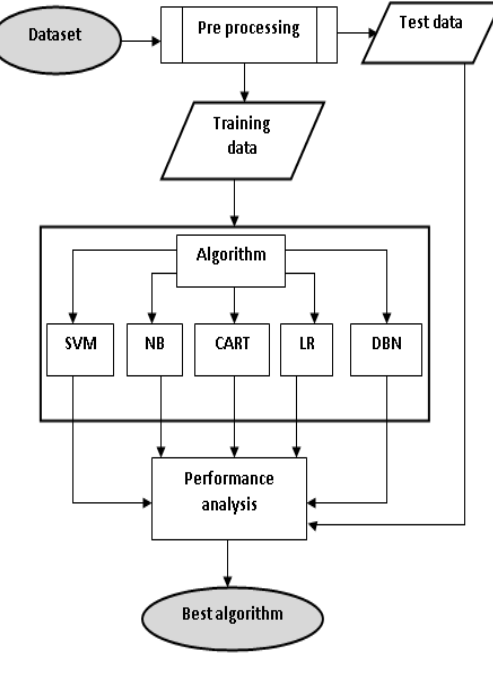
Figure 5. Density plot for each predictor variable by class